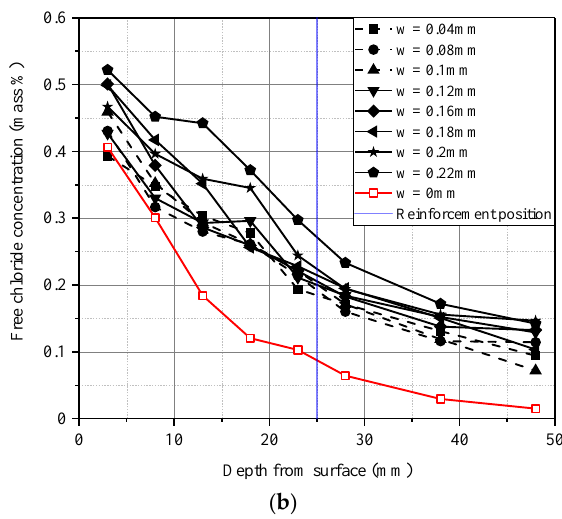
Figure 9. Free chloride profile for beam specimen series B-01 and B-02. ( a ) Beam specimen series B-01 (182 days); ( b ) Beam specimen series B-02 (364 days).